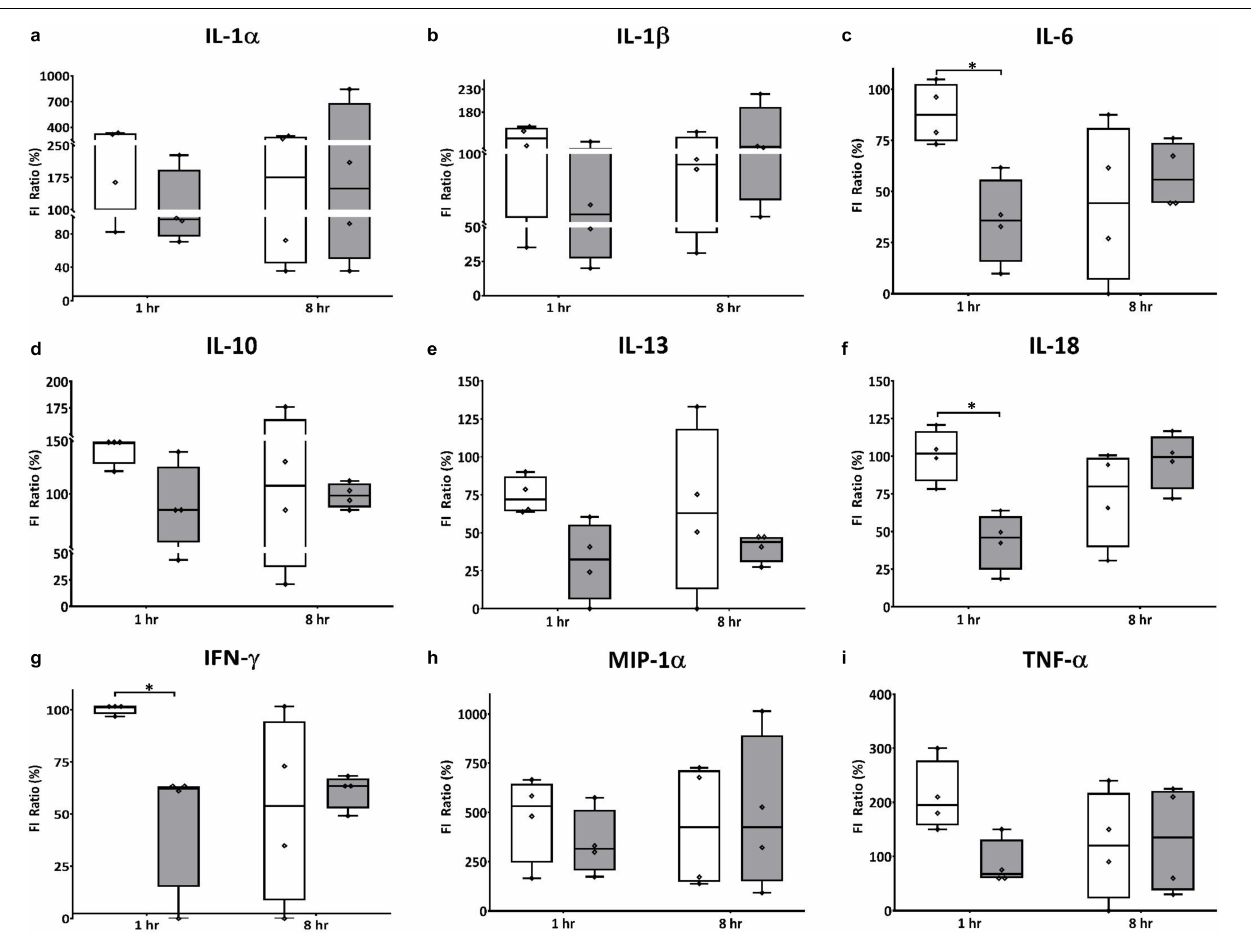
FIGURE 5 | HT decreases expression of cranial pro and anti-inflammatory effectors in neonatal HIE. HT significantly decreased expression of pro-inflammatorycytokine IL-18 (f) 1 h after therapy was initiated, but had no effect on IL-1 β expression (b) . While the differences did not reach statistical significance, HT also decreased expression of other pro-inflammatorycytokines IL-1 α (a) , MIP-1 α (h) and TNF- α (i) when compared to NT animals. Interestingly, HT also decreased the expression of anti-inflammatory mediators IL-10 (d) and IL-13 (e) , as well as the expression of IL-6 (c) and IFN- γ (g) , which have dual roles in inflammation, when compared to NT controls. ( n = 7 animals per group, white bars – NT; gray bars – HT; error bars denote ± SD, * denotes P <